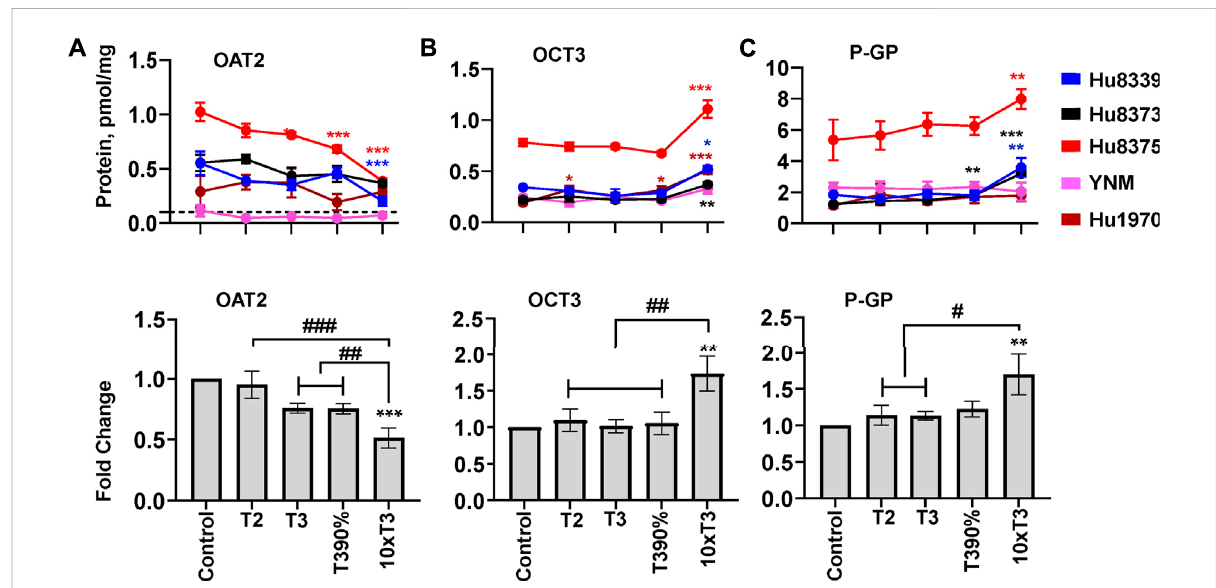
FIGURE 6 PRHs altered the absolute protein concentration of key transport proteins in SCHH. Human primary hepatocytes from quali fi ed donors were exposed to vehicle control or PRH cocktails. The PRH cocktails target average trimester 2 (T2), average trimester 3 (T3), upper range of T3 (T3-90%), and supraphysiological (10xT3) PRH concentrations (Table 1). The line graphs represent mean ± SEM absolute protein concentration of OAT2 (A) , OCT3 (B) , and P-GP (C) in SCHH in response to exposure to PRHs within each hepatocyte donor ( n = 3 – 4 biological replicates per group). The bargraphsbelowrepresentmean±SEMfold-changeforeachproteinrelativetocontrolacrossalldonors( n =4 – 5pergroup).Thedottedlineaty= 0.1 pmol/mg represents lower limits of quantitation. OAT2 was not quanti fi able in donor YNM, and thus the fold-change data for OAT2 included n